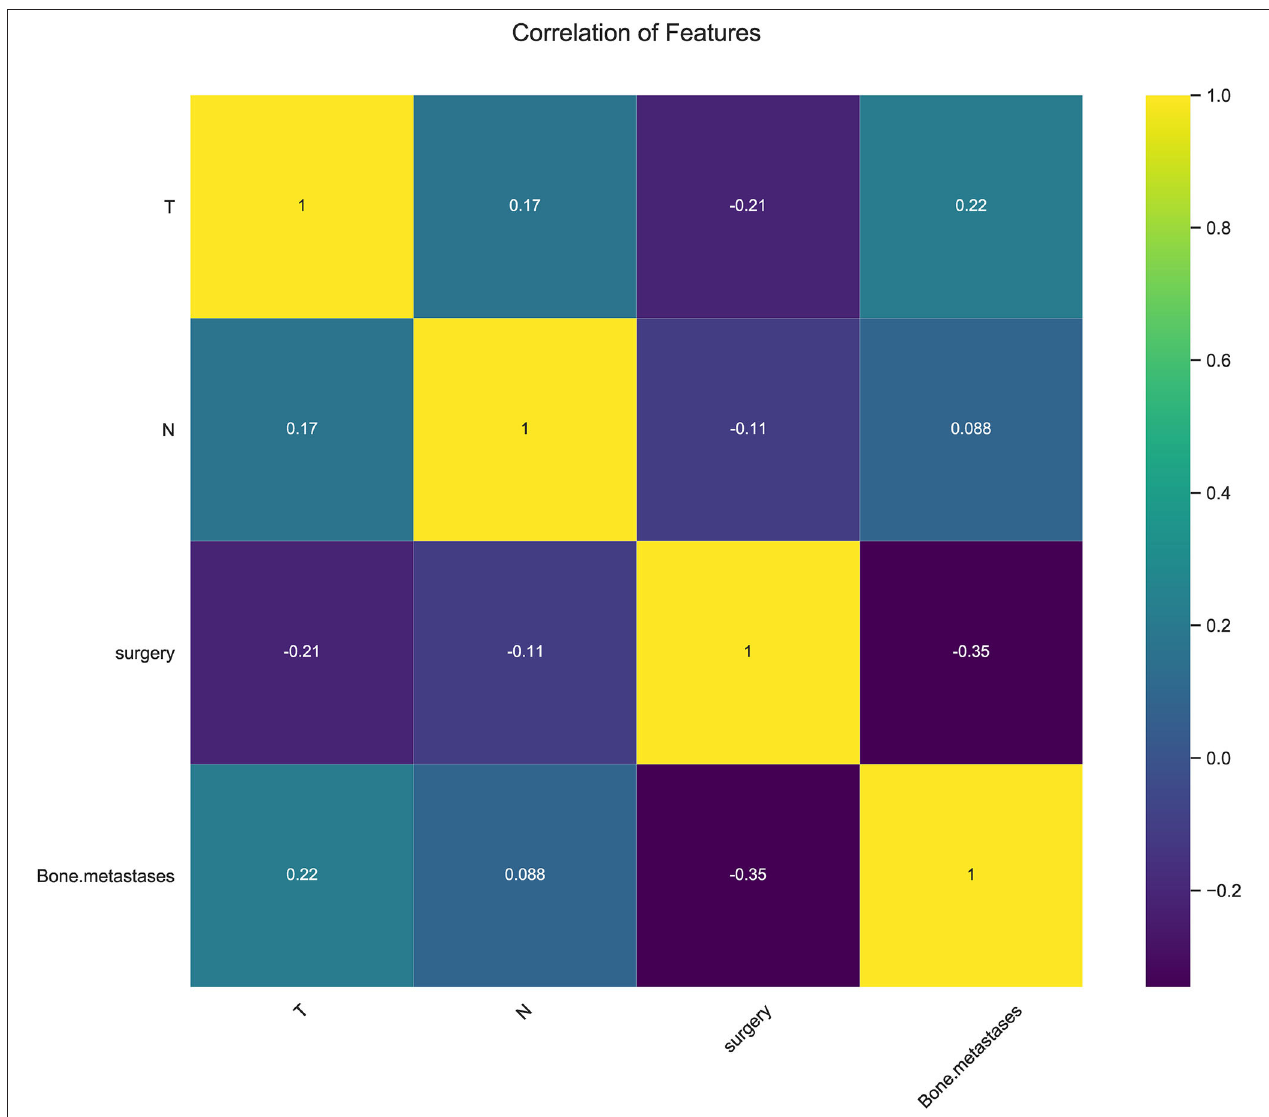
FIGURE 4 | Results of Pearson correlation of features analysis between all variables showing no obvious correlation between every two